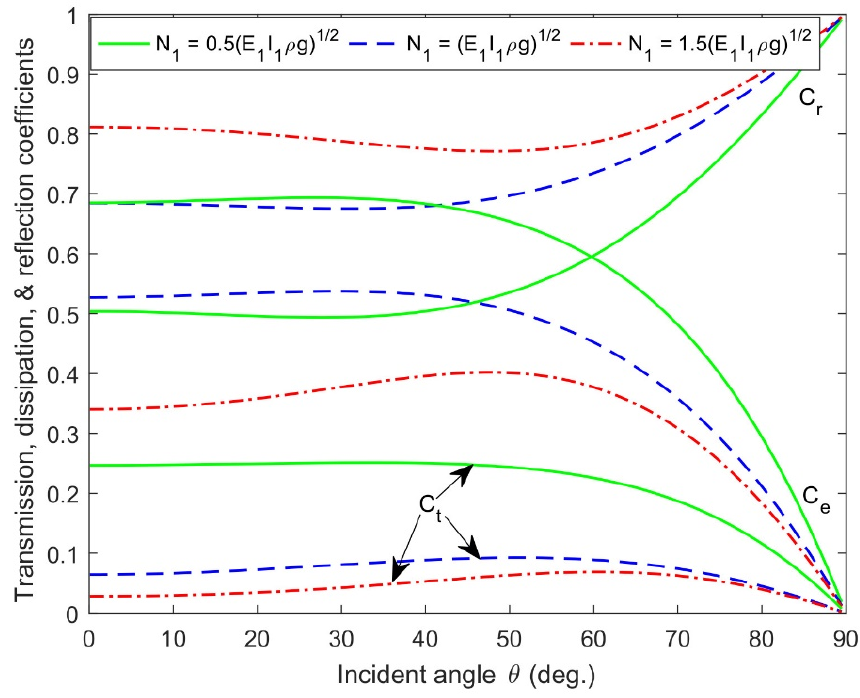
C , C and C versus θ for different compressive forces, N . Figure 4. Effects of the C r , C t and C e versus θ for different compressive forces, N Figure 4. Effects of the 1 . r t e 1 In Figure 5, the comparison results of the C r , C t and C e for various d / h versus angles θ are simulated. More importantly, the dissipation coefficient increases with an increase in the values of depth of submergence d / h , while the effect of transmission coefficient is negligible, as seen in Figure 5, which is due to a large portion of the wave energy being absorbed by the submerged porous plate.